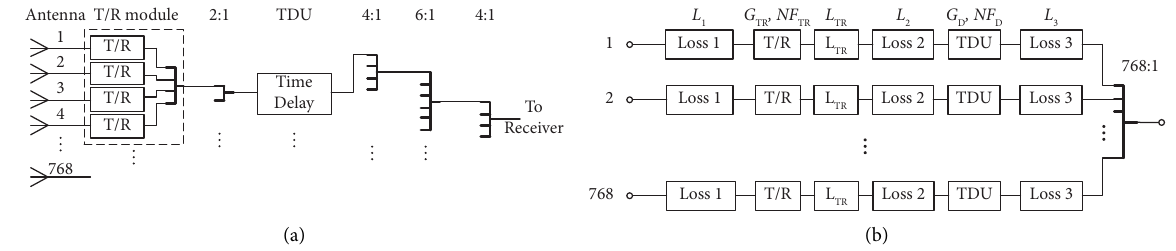
Figure 8: (a) Block diagram of GF-3 SAR antenna. (b) Te noise model for the SAR antenna. Table 1: Parameters of the noise model for GF-3 SAR antenna.